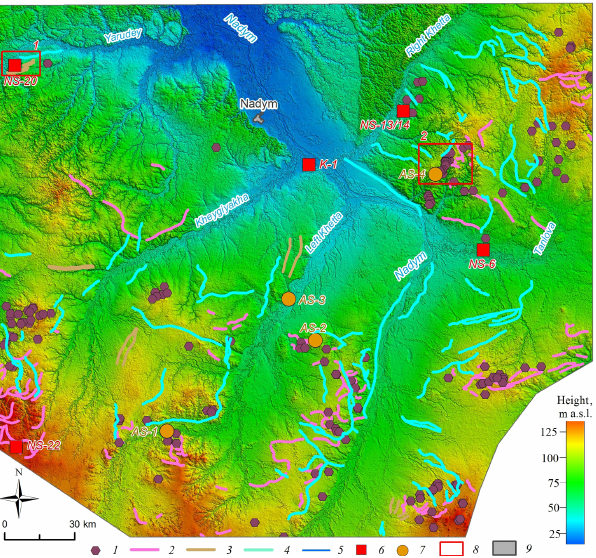
Figure 9. Results of the glacial and fluvioglacial relief inter- pretation in the middle course of the Nadym River (the back- ground image is based on TanDEM-X DEM © DLR, 26m/px): (1) kame-like hummocks; (2) moraines; (3) parallel ridges; (4) valley trains; (5) waterways; (6) studied and sampled locations; (7) ad- ditional locations based on Khlebnikov (1954) and Yevseyev and Reynin (1958); (8) areas of typically glacial landforms; (9) settle- ments (objects 1-4,6,7 are available in GIS-format at Sizov,